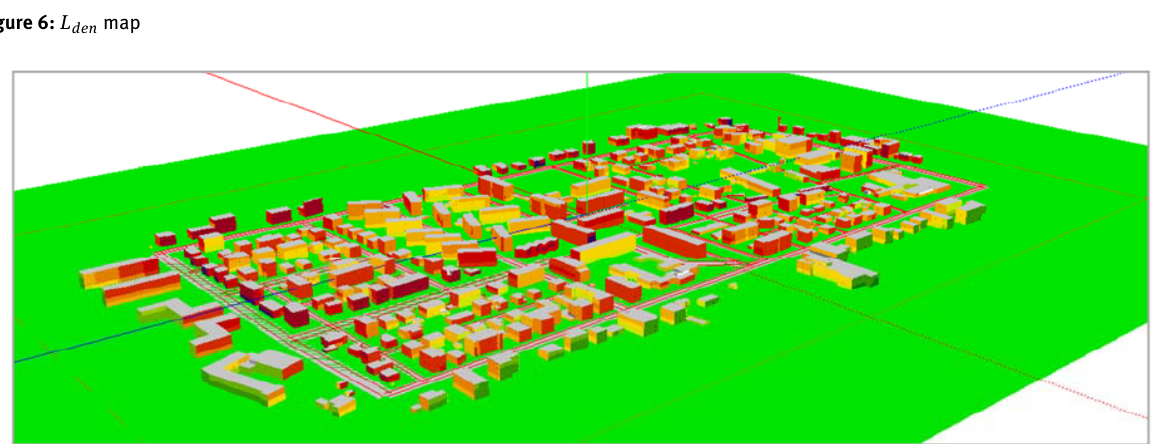
sponding to the maximum value of the whole area), gives different values for the two roads (respectively related to 40 pop/100m and 37 pop/100m). Considering the weight- (Table 1), AQI is equal to 79.9 for Strada della Paiola, and equal to 75.4 for Viale Lodi. Referring to the AQI classifi- cation (Table 2), the global score corresponds to a “Good” level.